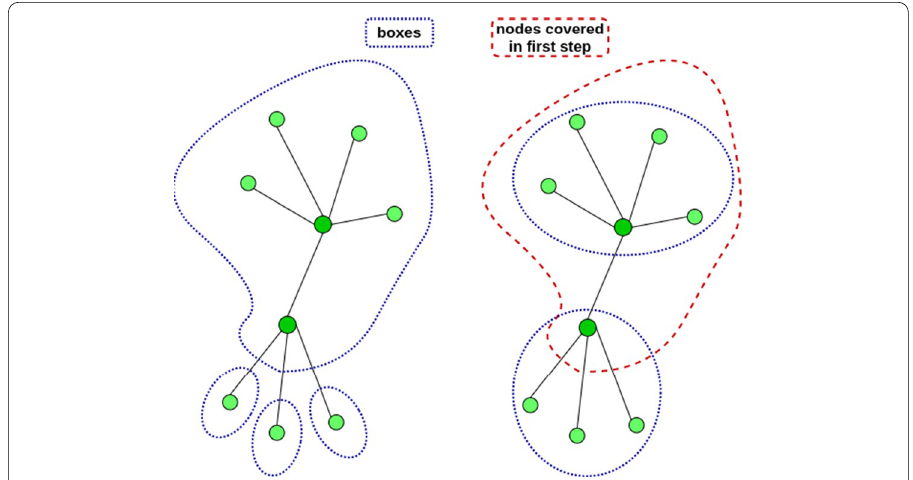
Fig. 4 The motivation for MEMB’s center assignment strategy shown on a small-sized example. The left figure shows a box cover when only uncovered nodes can serve as seeds. The right figure illustrates the strength